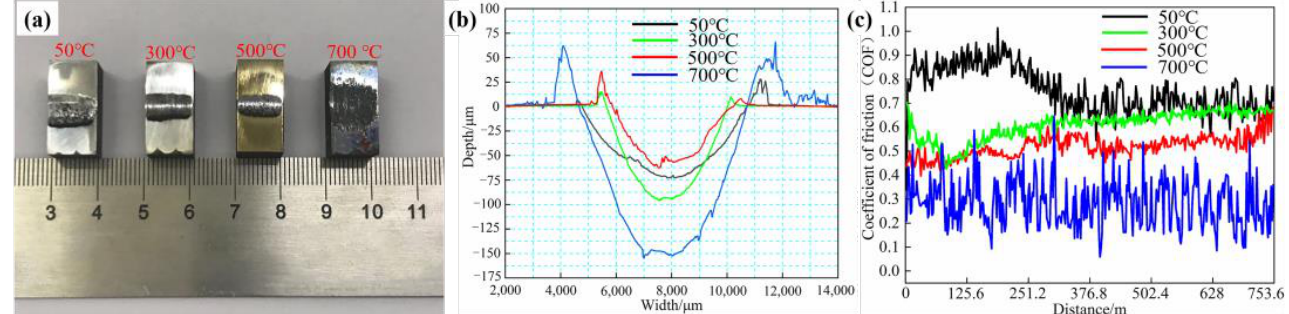
Figure 6. Different temperatures under 200 N: ( a ) surface of FeCrSiNiCoC samples after wear test; ( b ) measurements of typical wear surface morphology using sample wear track sections; ( c ) COF distance curves of samples. Table 3. Wear width, wear depth and wear rate of coatings at various temperatures. Temperature Wear Width/( µ m) Wear Depth/( µ m)